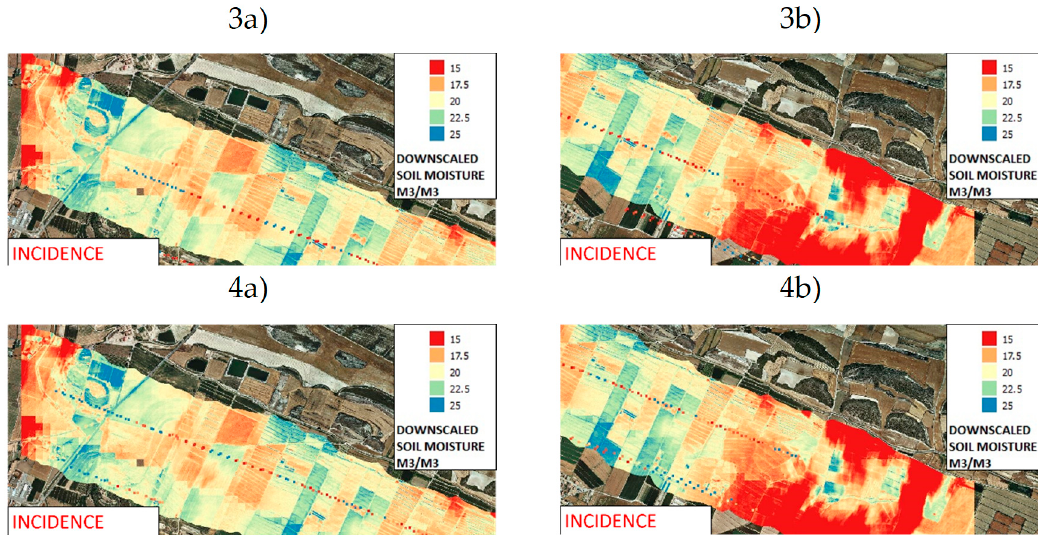
Figure 18. ARIEL and GNSS-R retrieved SM, as a function of the incidence angle in steps of 15 ° : 1) 0 ° –15 ° , 2) 15 ° –30 ° , 3) 30 ° –45 ° , and 4) 45 ° –60 ° . Figures ( a ) and ( b ) correspond to rectangles A and B in